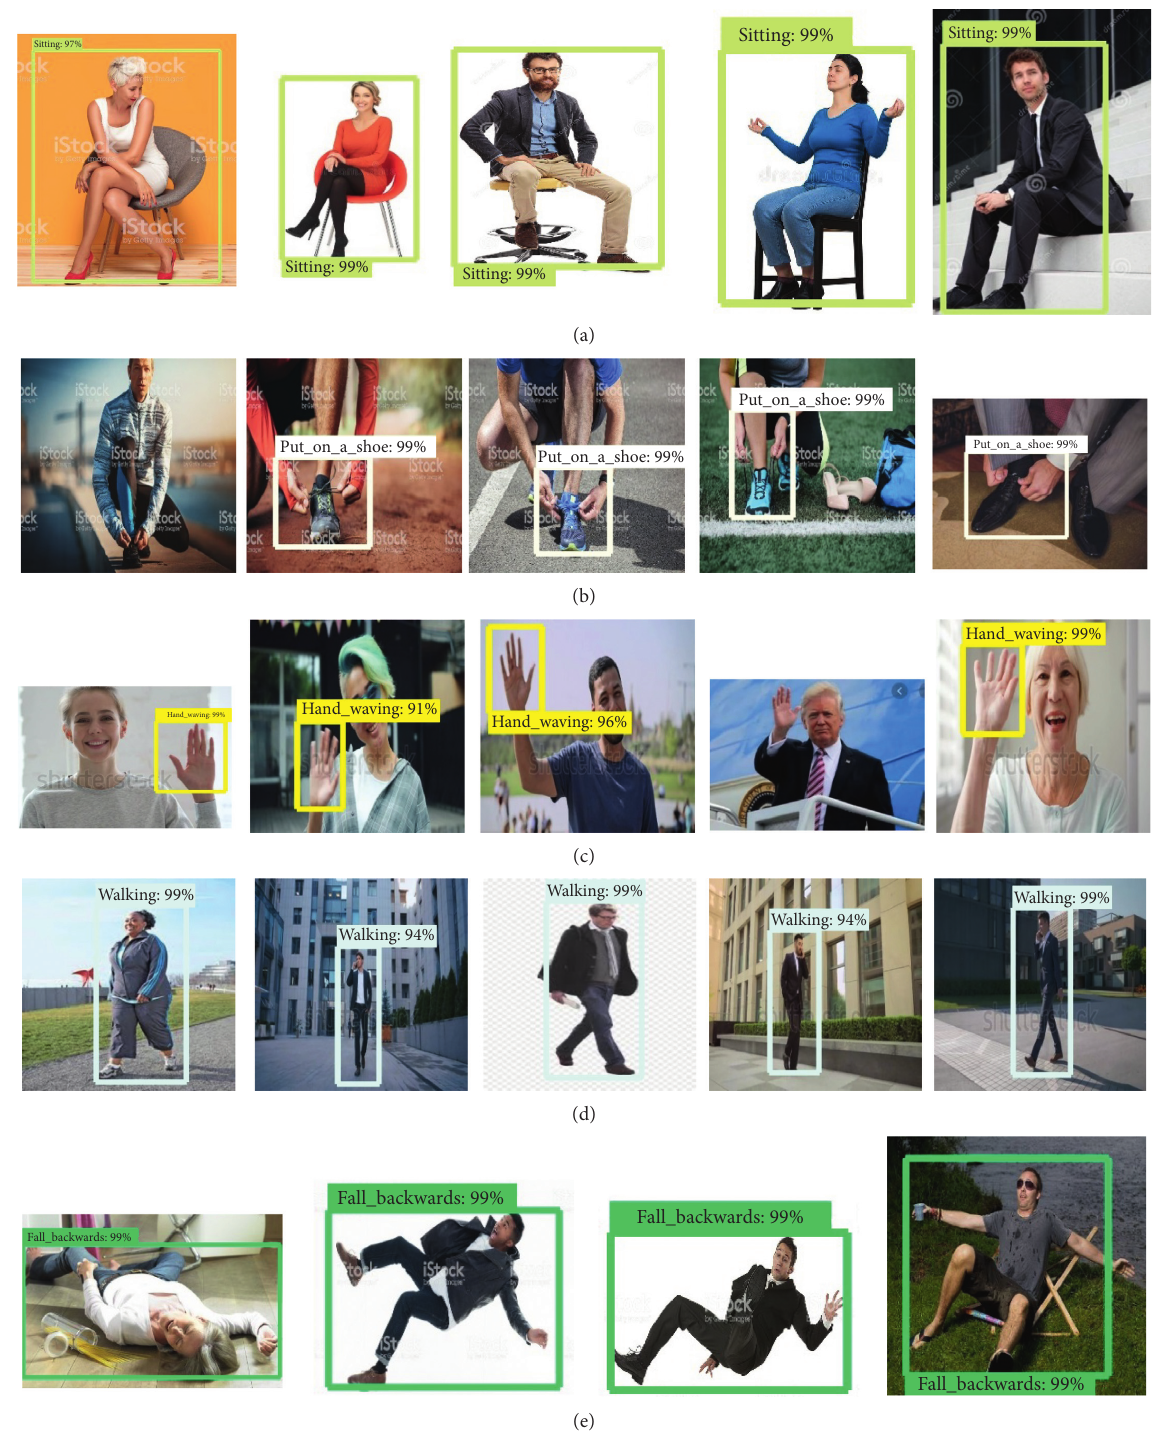
Figure 19: Training results with the proposal model (SSD+MobilenetV2) for (a) sitting down, (b) wearing shoes, (c) waving hands, (d) walking, and (e) falling